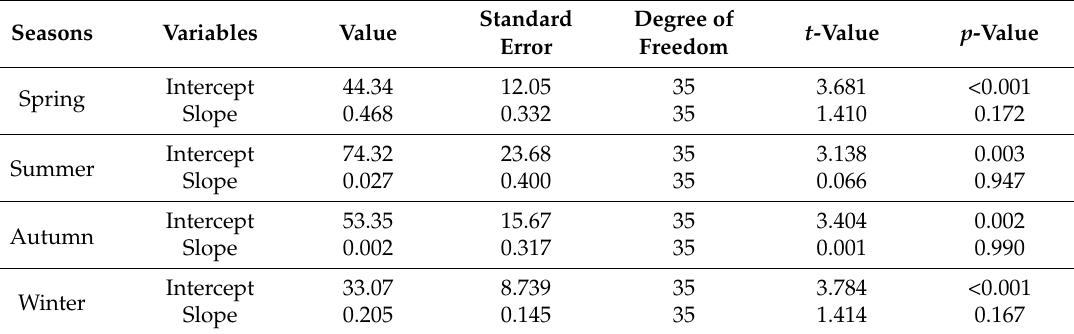
Table 3. Linear Mixed Effects Model analyses for the relationship between phytoplankton species richness and copepod abundance in different seasons.